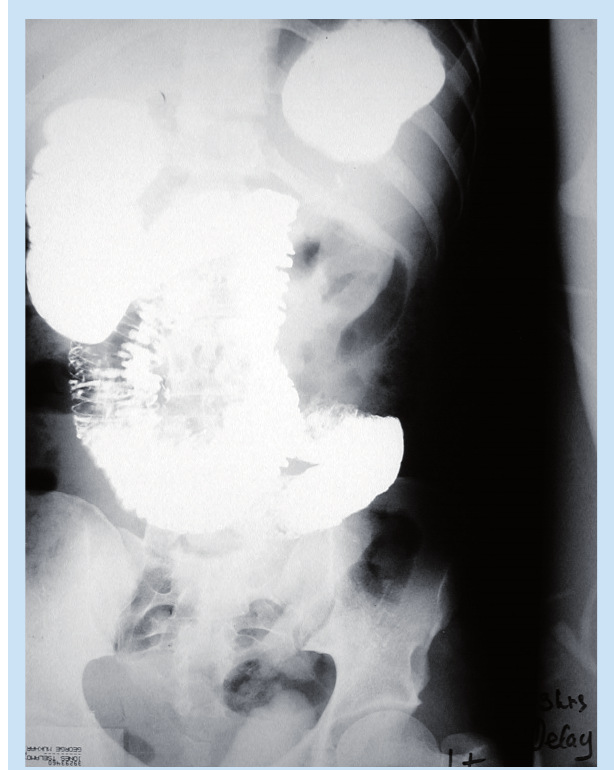
Fig. 3. A 45-minute delay film shows the encapsulated cluster of jejenum loops in the right midabdomen in the fossa of